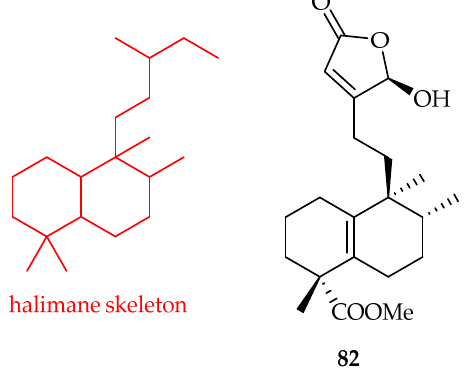
Figure 33. Structure of crassin H 82 [51].